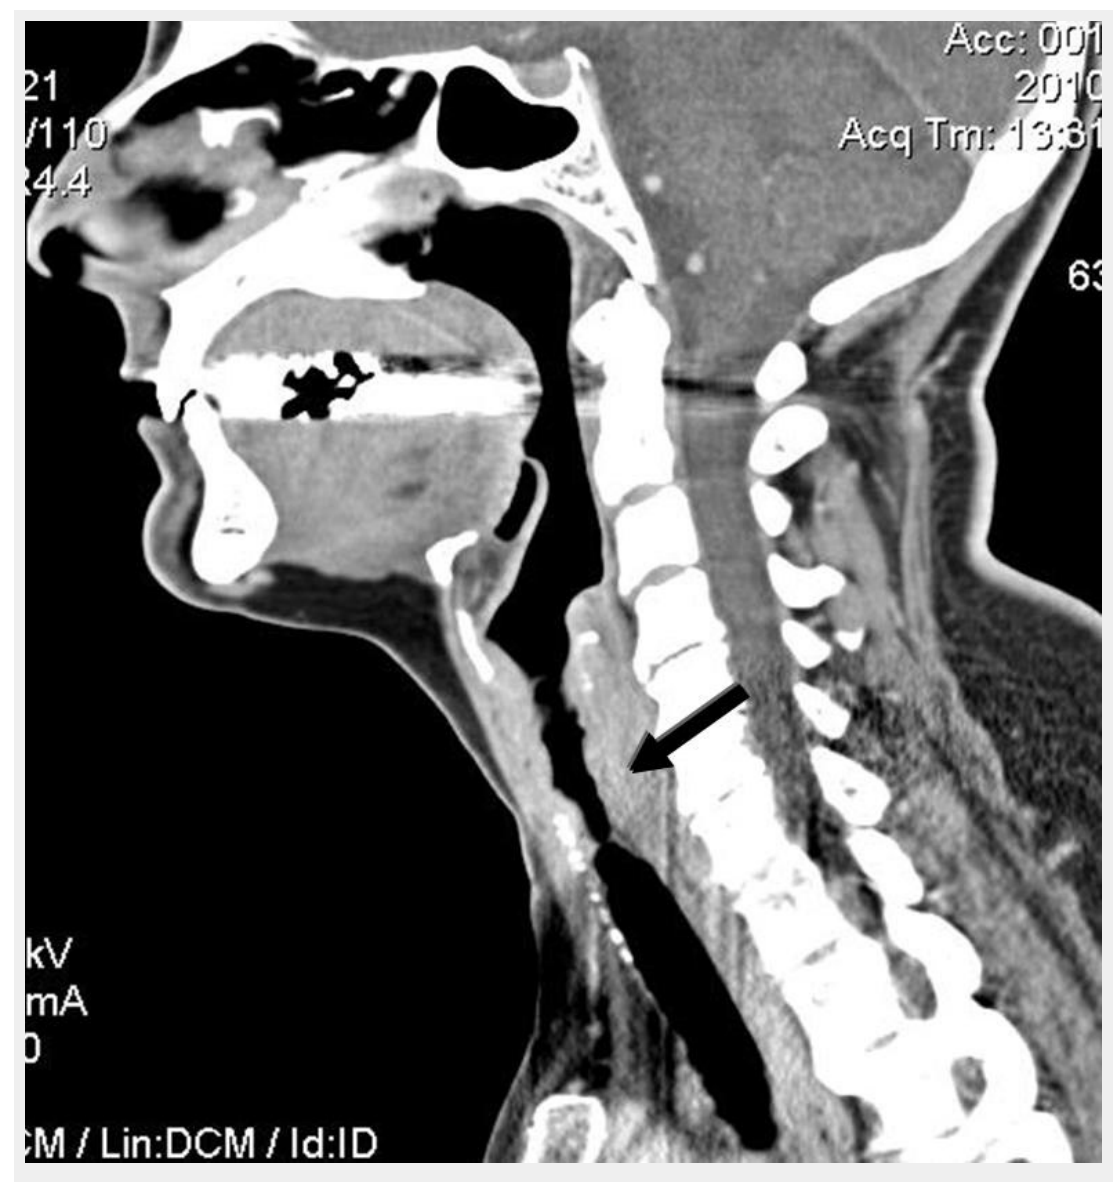
Figure 4 CT scan of the neck of a patient with GPA showing 6-cm-long subglottic stenosis